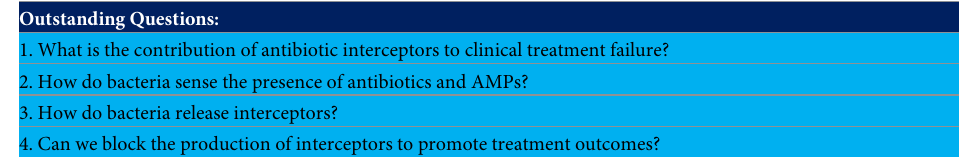
Table 2. Outstanding